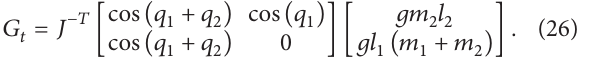
Figure 7: The positions of the master and the slave in task space without adaptive regulator.